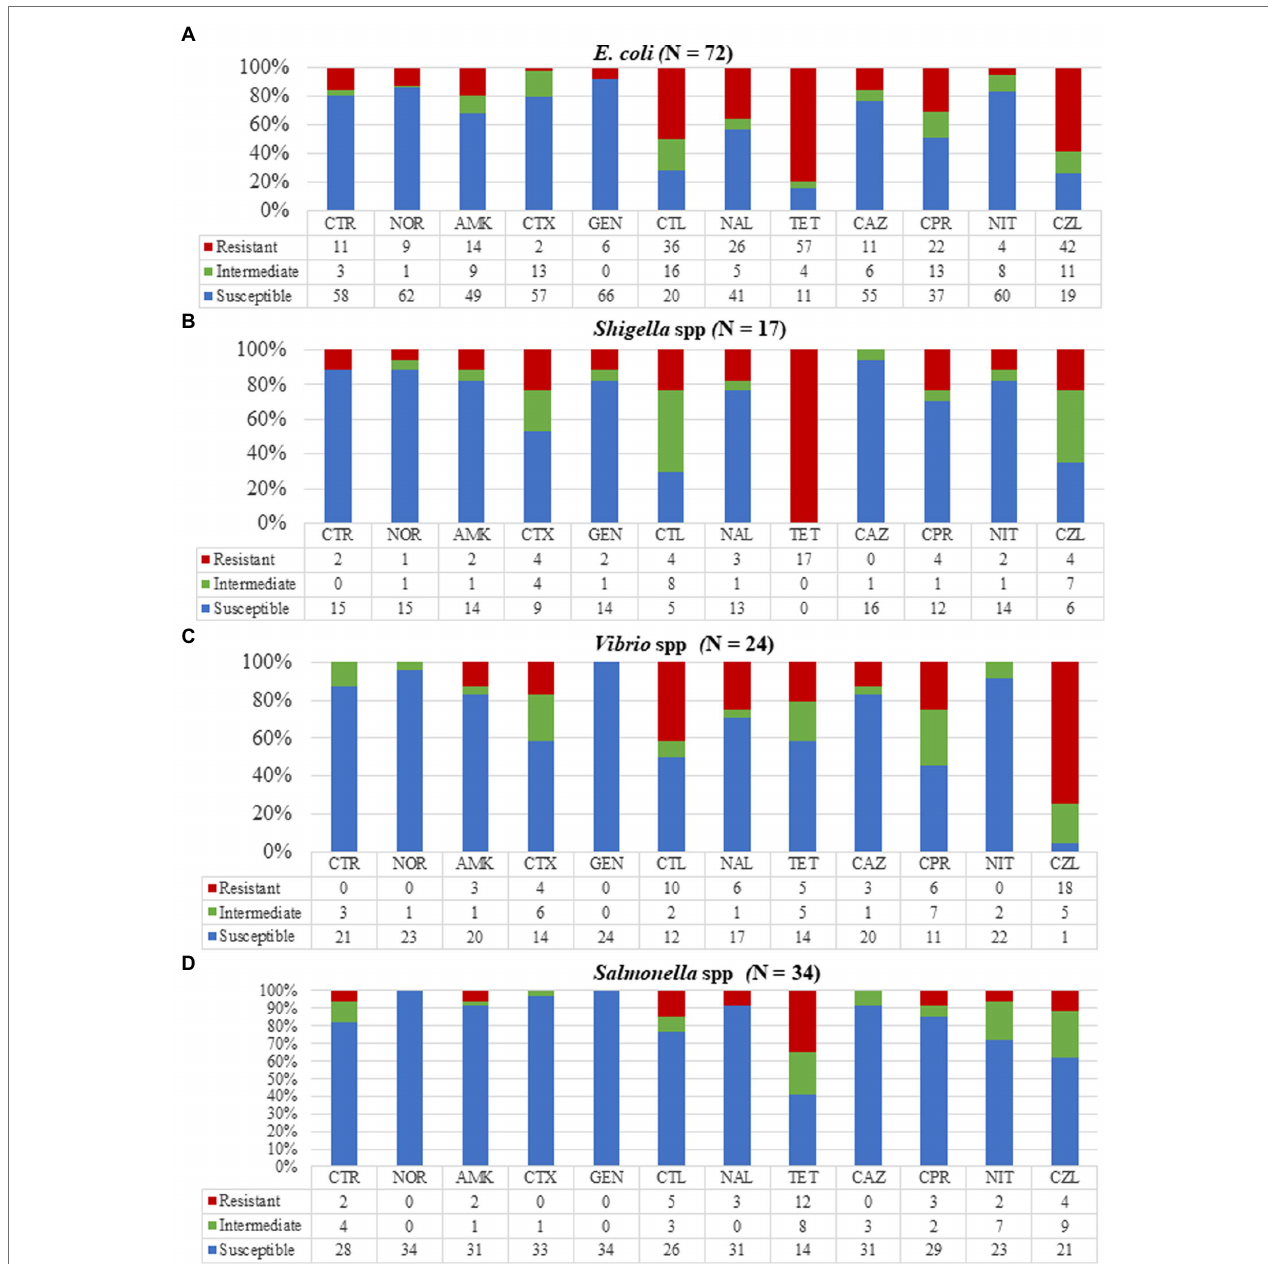
FIGURE 3 | Resistance patterns of the various bacterial strains to 12 antibiotics. (A) Escherichia coli showing high resistance to tetracycline, cephalothin, and cefazolin. (B) Shigella isolates were totally resistant to tetracycline with no resistance to ceftazidime. (C) Vibrio isolates showed high resistance to cefazolin and complete susceptibility to gentamycin. (D) All Salmonella isolates were susceptible to norfloxacin, cefotaxime, and gentamycin with 35% of isolates resistant to tetracycline. CTR, ceftriaxone; NOR, norfloxacin; AMK, amikacin; CTX, cefotaxime; GEN, gentamycin; CTL, cephalothin; NAL, nalidixic acid; TET, tetracycline; CAZ, ceftazidime; CPR, ciprofloxacin; NIT, nitrofurantoin; and CZL,